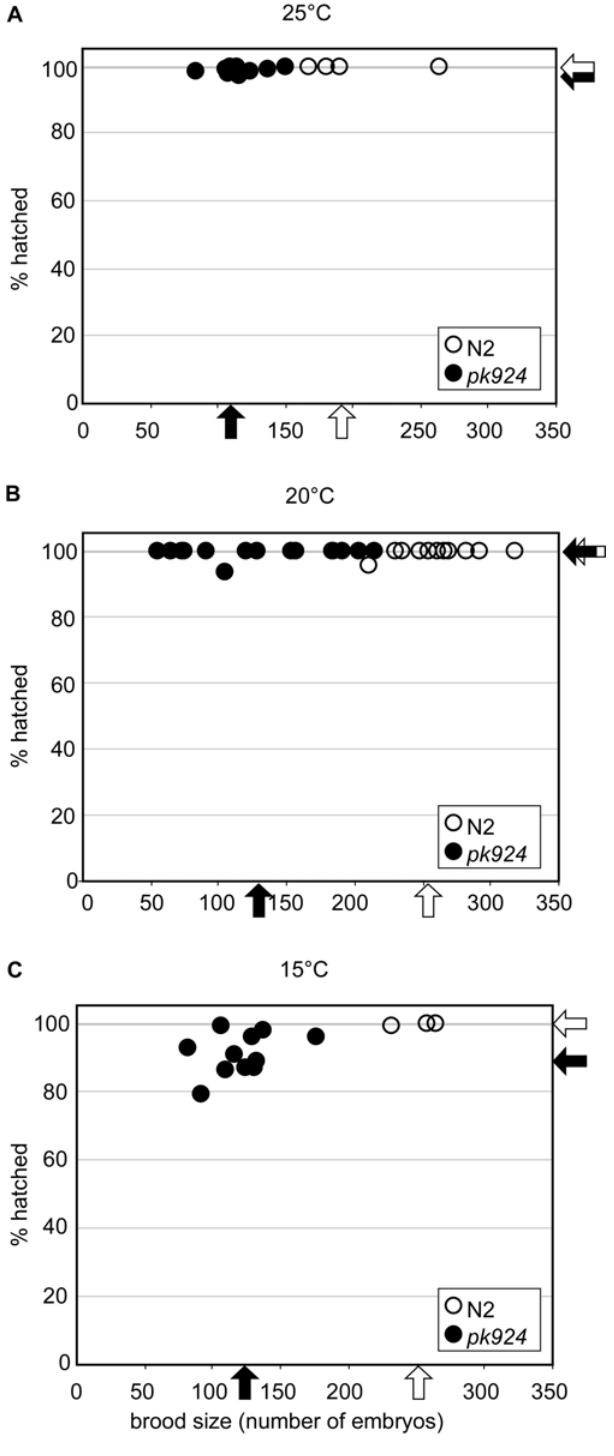
Figure 2. pk924 mutant worms have small brood sizes and cold- sensitive embryonic lethal phenotypes. The results of brood size and progeny analysis at three different temperatures are shown: (A) 25 u C, (B) 20 u C, and (C) 15 u C. The X-axis of the graphs represents the brood size, which is the number of progeny of one worm. The Y-axis represents the percentage of viable embryos in the progeny of one worm (% hatched). A filled circle represents a pk924 worm and an open circle represents a wild-type (N2) worm. Arrows indicate the average brood size and hatching rate of either pk924 worms (solid arrows) or wild-type worms (open arrows).